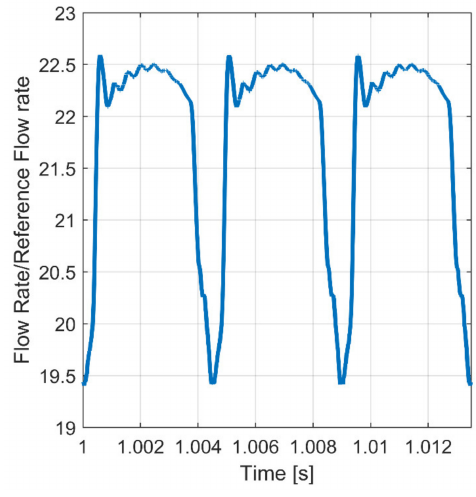
Figure 4. Flow rate at 1500 r/min, 250 bar.